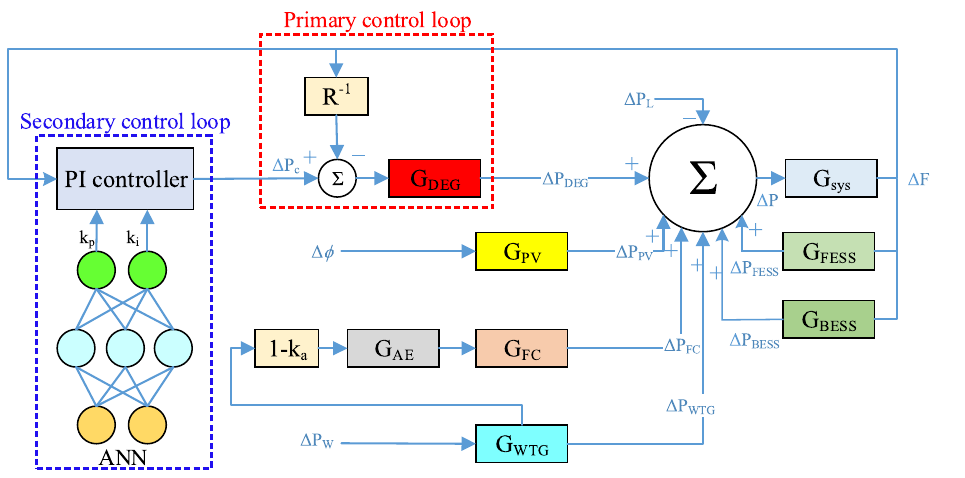
Figure 7. Microgrid frequency response model.